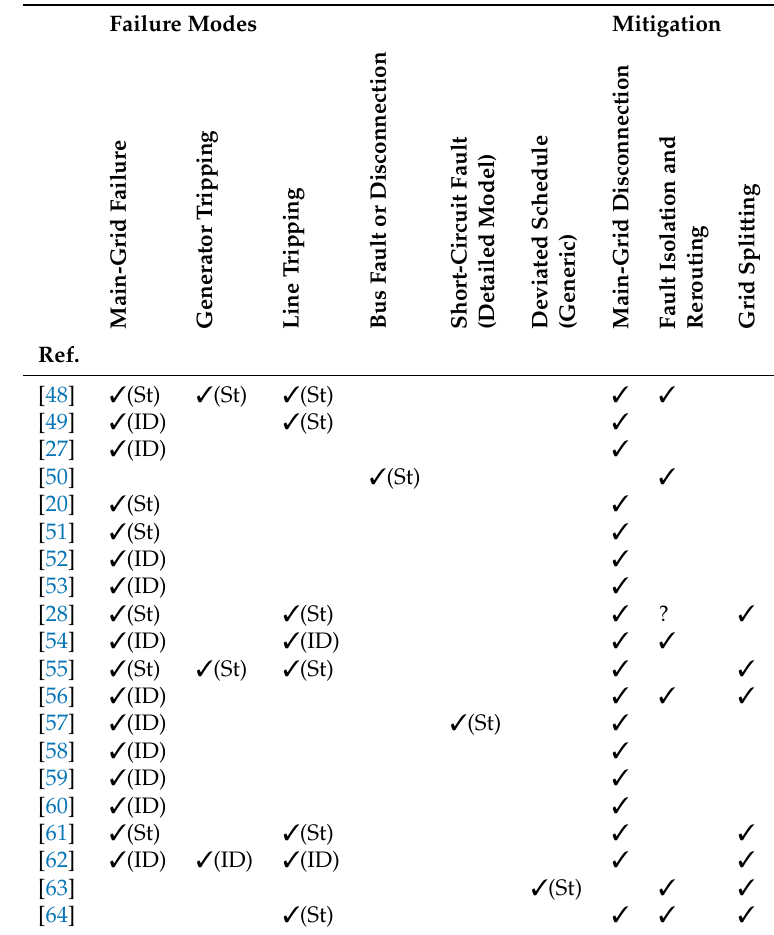
Table 7. Resilience features ( (cid:51) : Implemented, ?: Not reported, St: Stochastic, D: Deterministic, ID: Indeterministic)